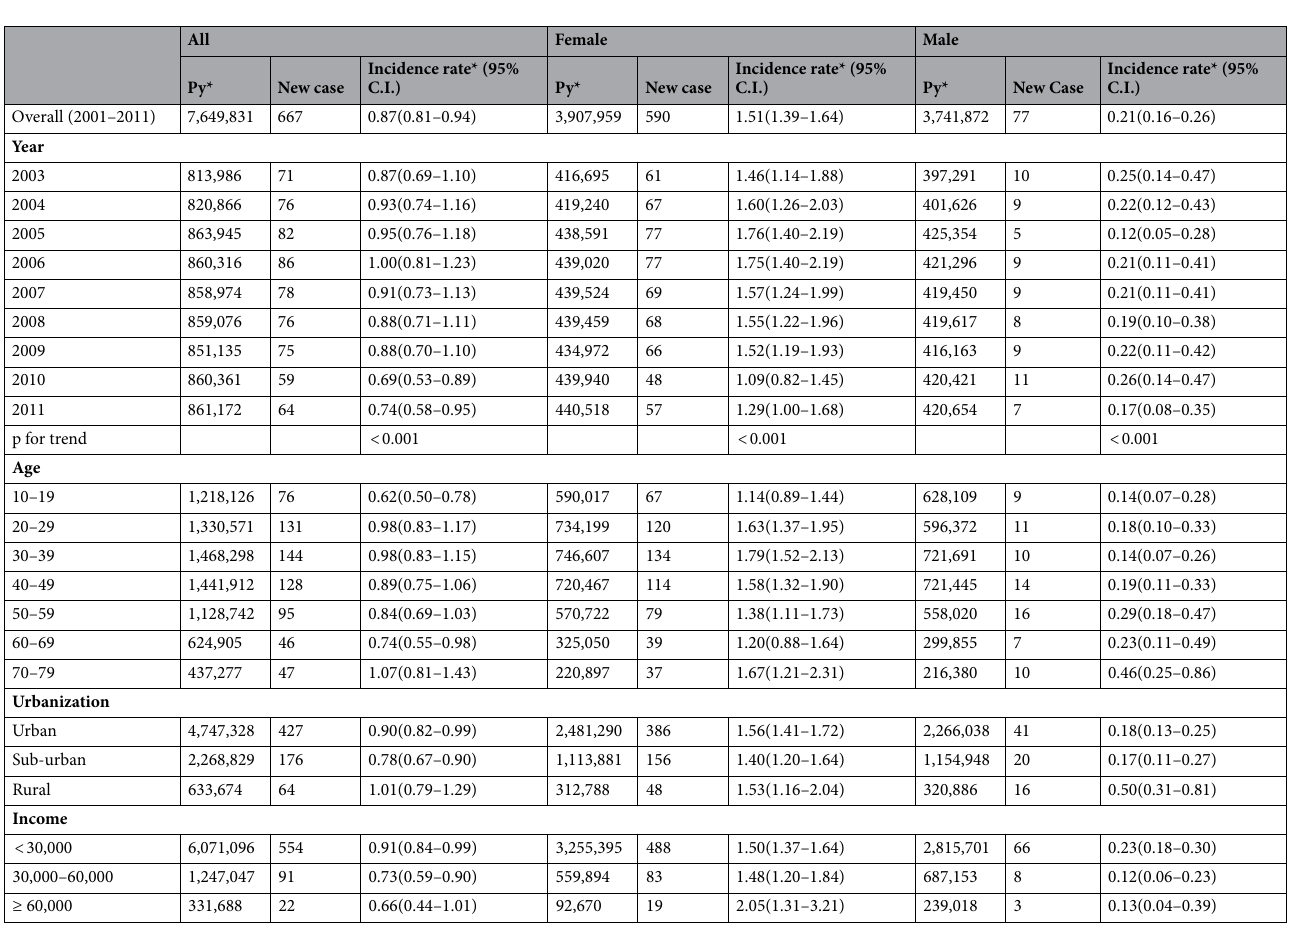
Table 3. The incidence rate (per 10 4 person years) of SLE among 10–79 years old people in Taiwan from 2003 to 2011 by specific